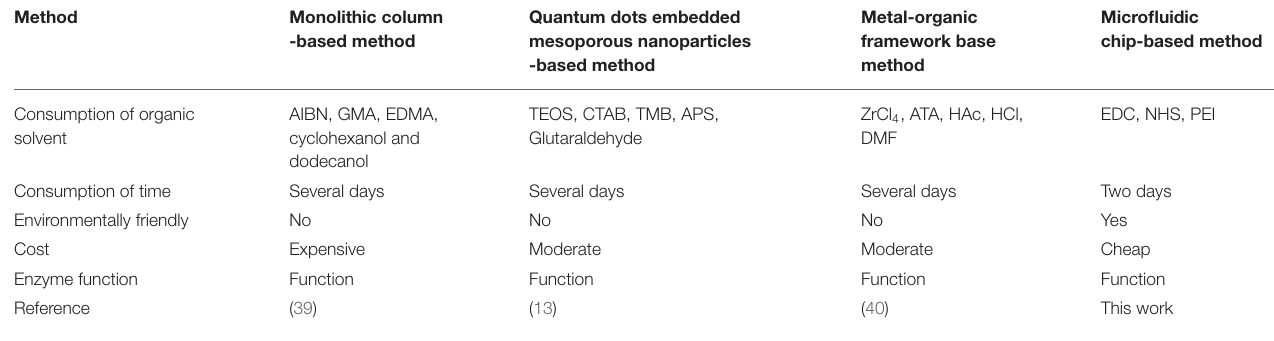
TABLE 3 | A comparison between the previous ligand fishing method and this